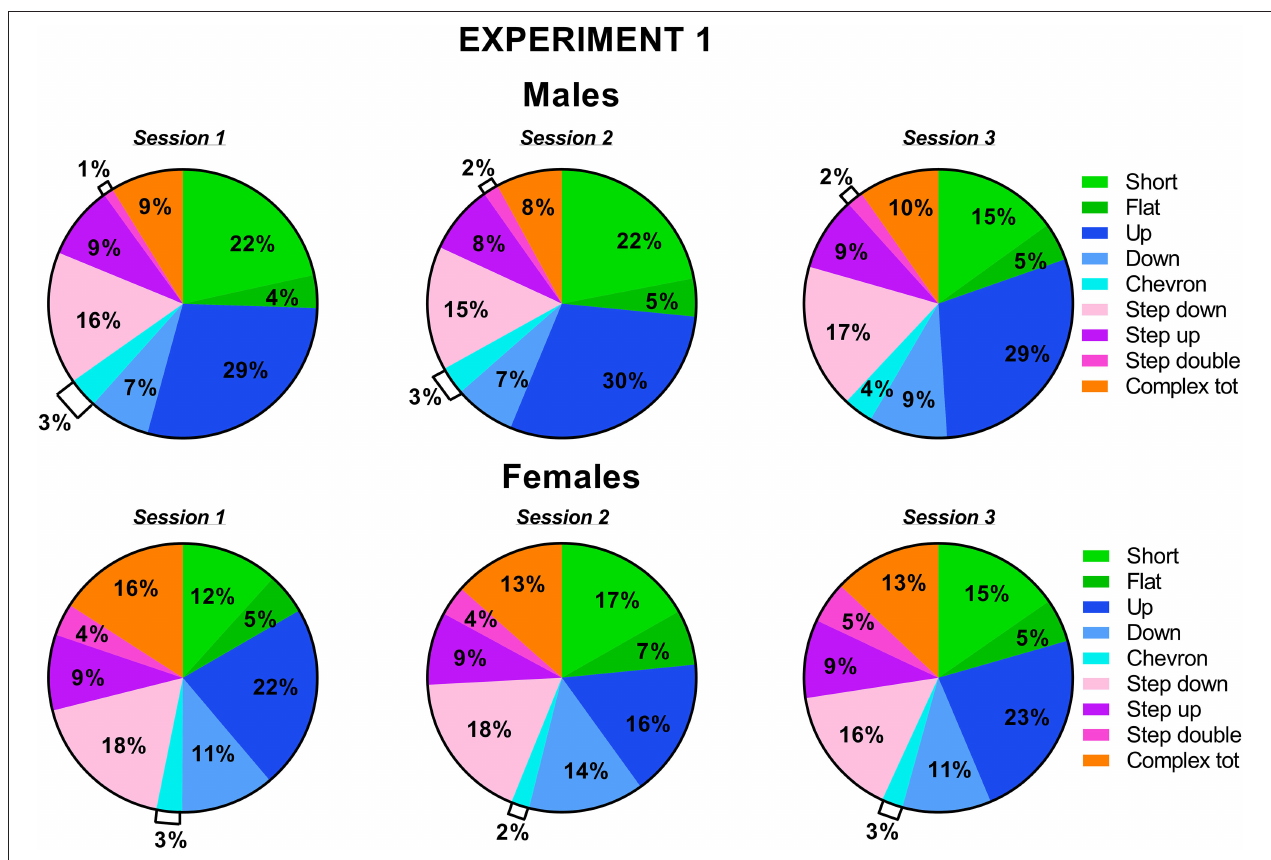
FIGURE 4 | Pie charts depicting sex differences in ultrasonic call types in experiment 1 (same pre-testing isolation). Distribution of call categories in each sex and testing session. Data are expressed as percentages over the total number of USVs for each sex and session. Data are mean ± SEM. N = 10 for each sex. Complex tot = complex 3 + complex 4 + complex 5 (refer also to Figure 1